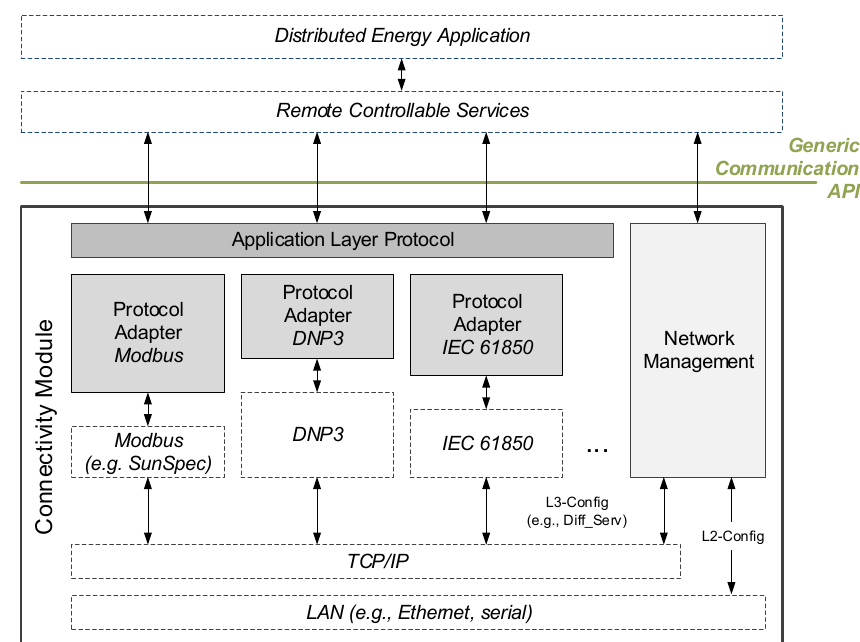
Figure 4. Overview of the overall system architecture (adopted from Reference [4]).